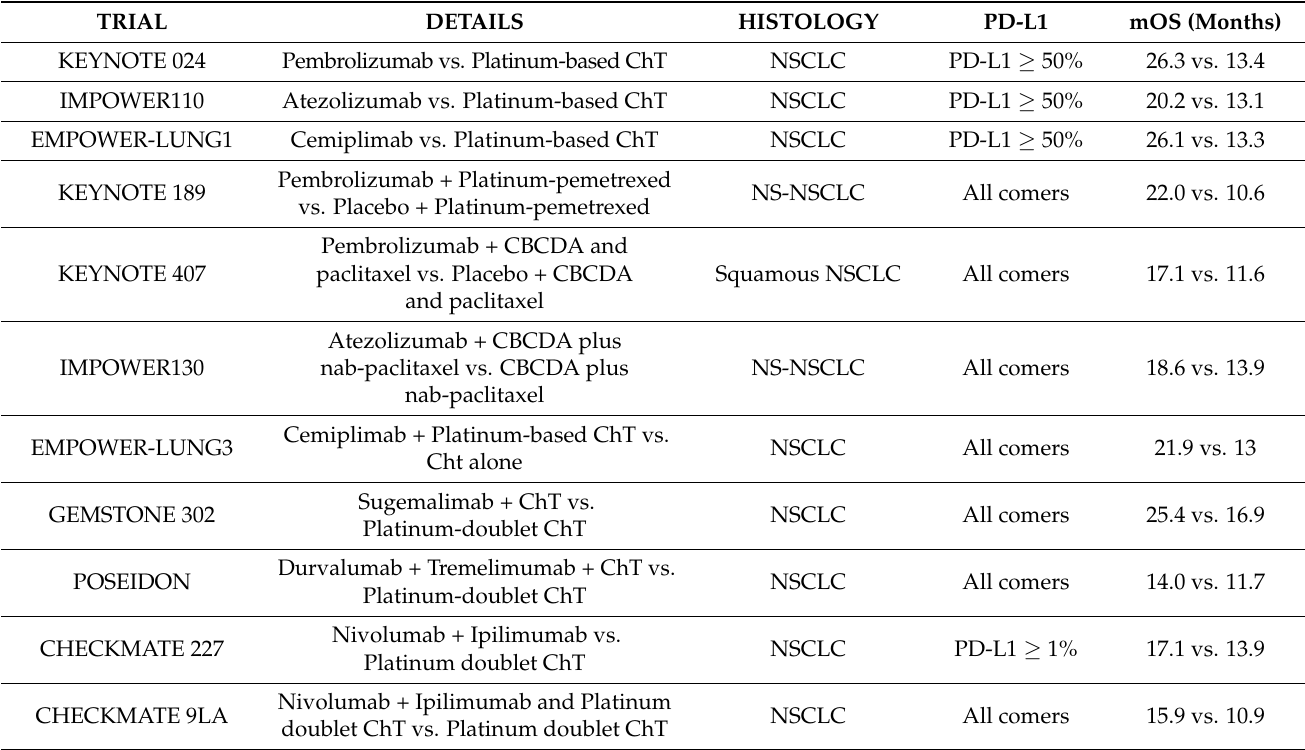
Table 1. First-line immunotherapy for mNSCLC: phase 3 trials showing OS benefit from ICIs.